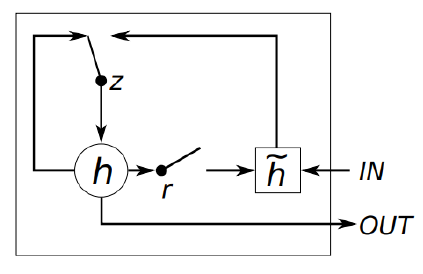
Figure 4. Illustration of GRU. r , z , h , and h are reset gate, update gate, the activation and the candidate activate, respectively. This GRU diagram is from Chung et al.